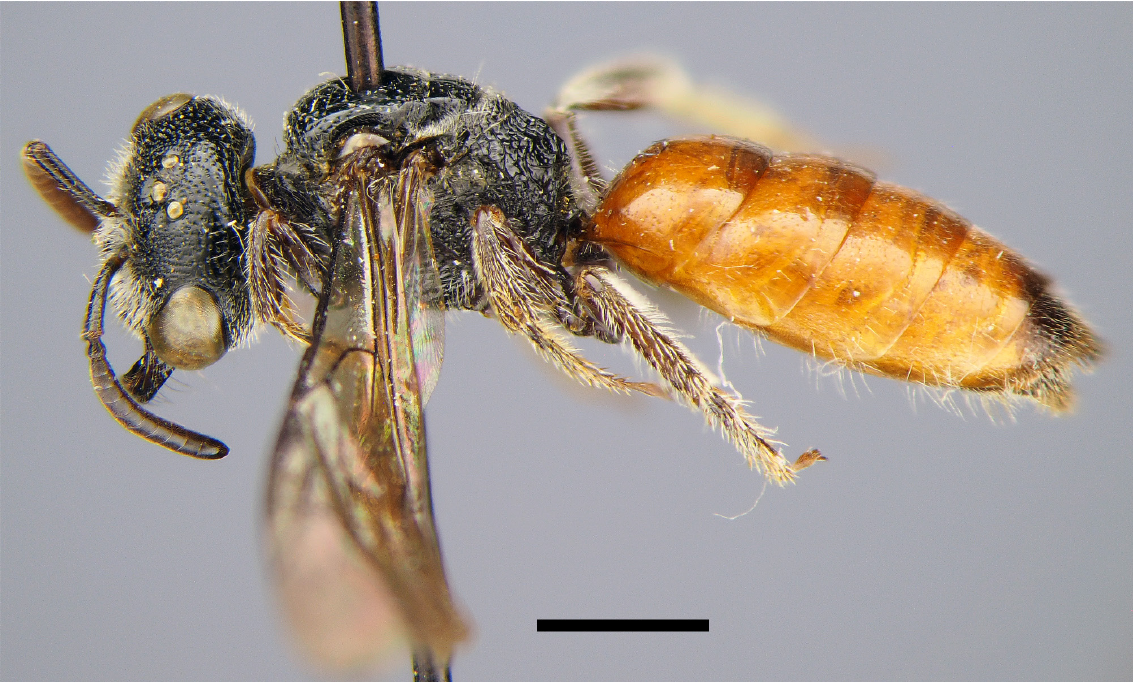
Fig. 12. Sphecodes lasimensis Blüthgen, 1927, ♀ (PCMS). Habitus in lateral view. Scale bar = 1